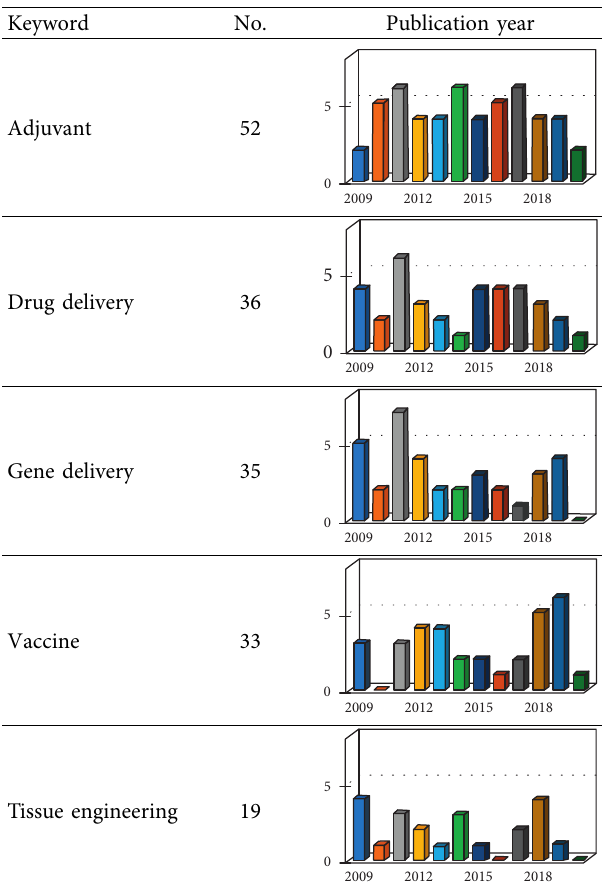
Table 2: Top five keywords in chitosan-related viral disease research.